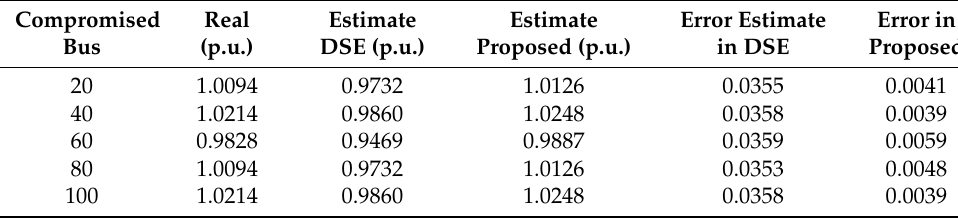
Figure 2. Estimate data collected using DSE WLS and Proposed technique. Table 1. Compromised Bus numbers with Error.